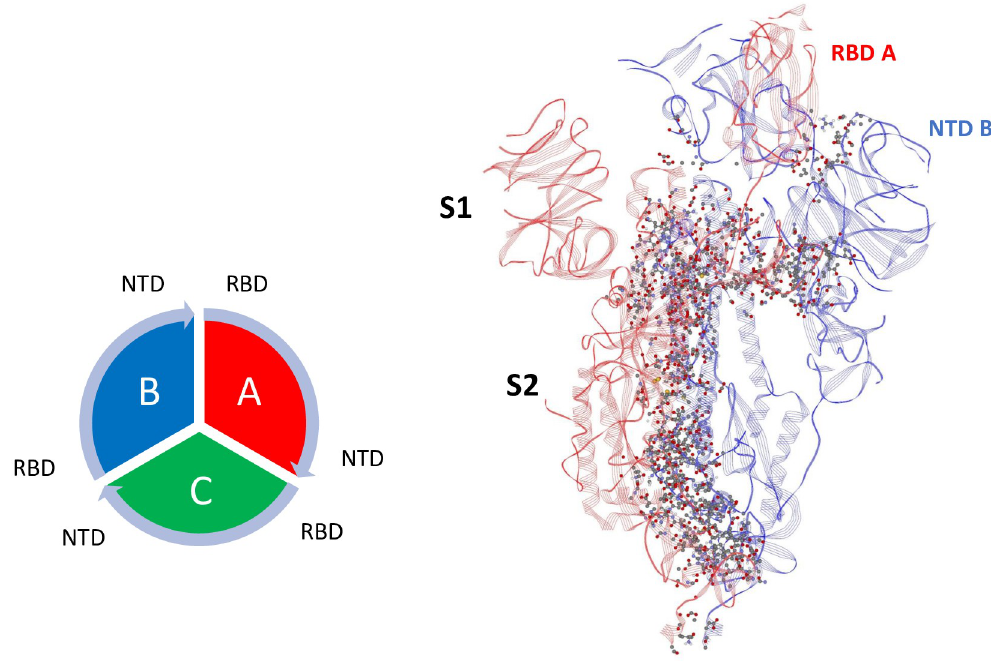
Fig 1. Dominant energy landscape for the interaction of chain A (Up; red) with chain B (Down; blue) for 6VSB. The dominant atom-atom interactions are shown by ball and sticks. Also shown is the overall chain interaction configuration looking at the trimer from the top view.